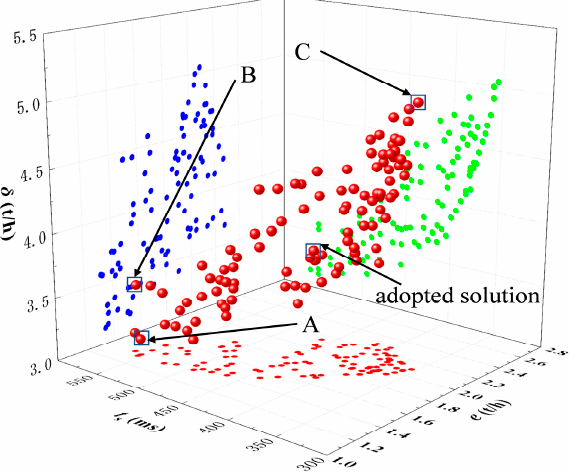
Figure 22. Improved NSGA- Ⅱ algorithm optimizing solution set. Table 3. NSGA-II solution results.